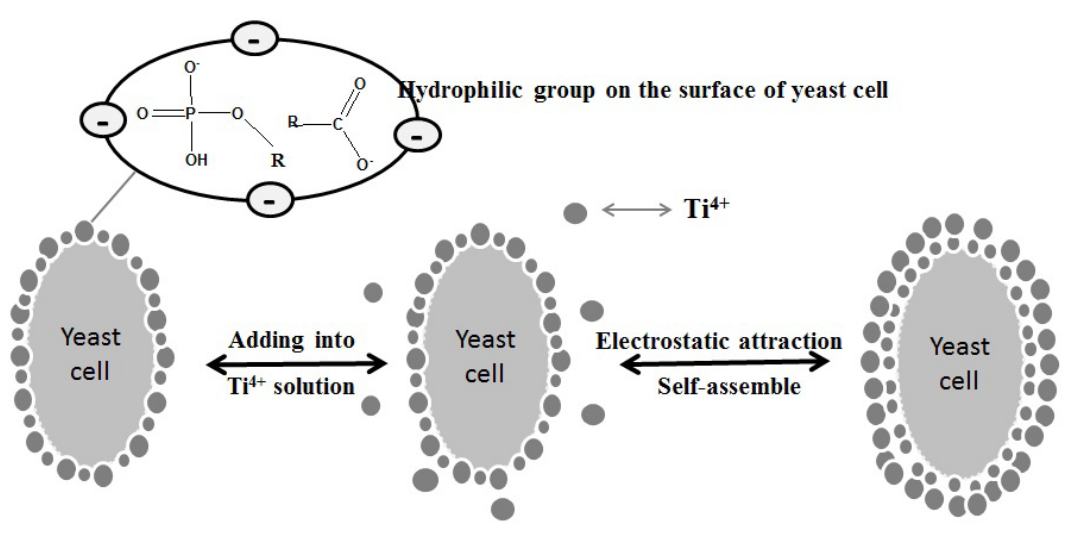
Figure 6. Preparation process of ordered hierarchical mesoporous TiO